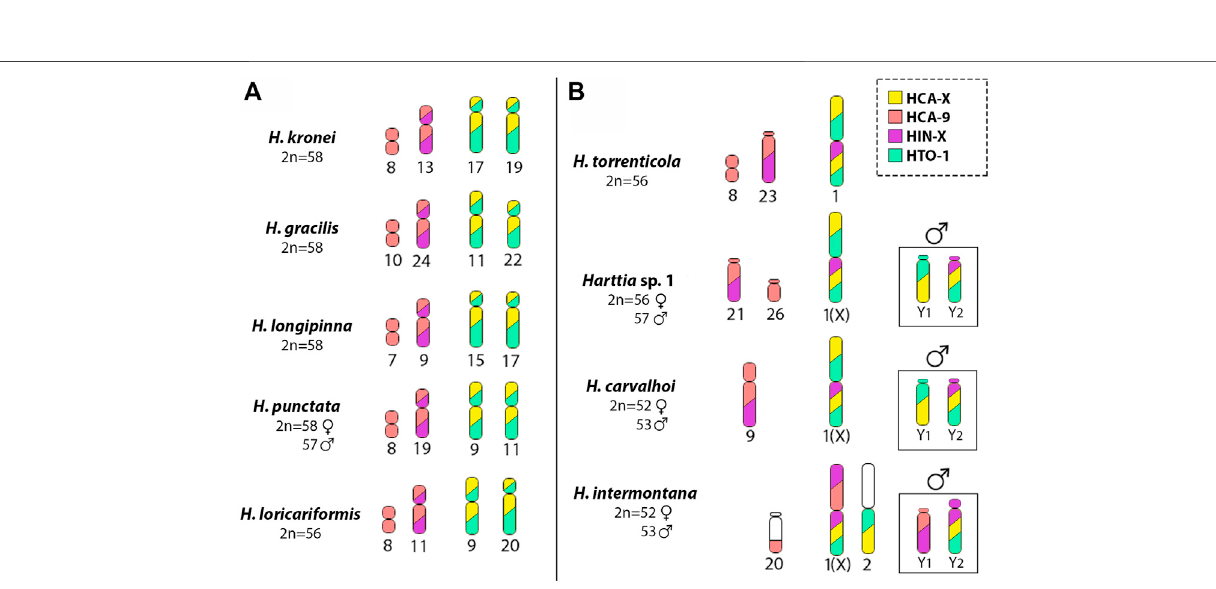
Frontiers in Genetics |